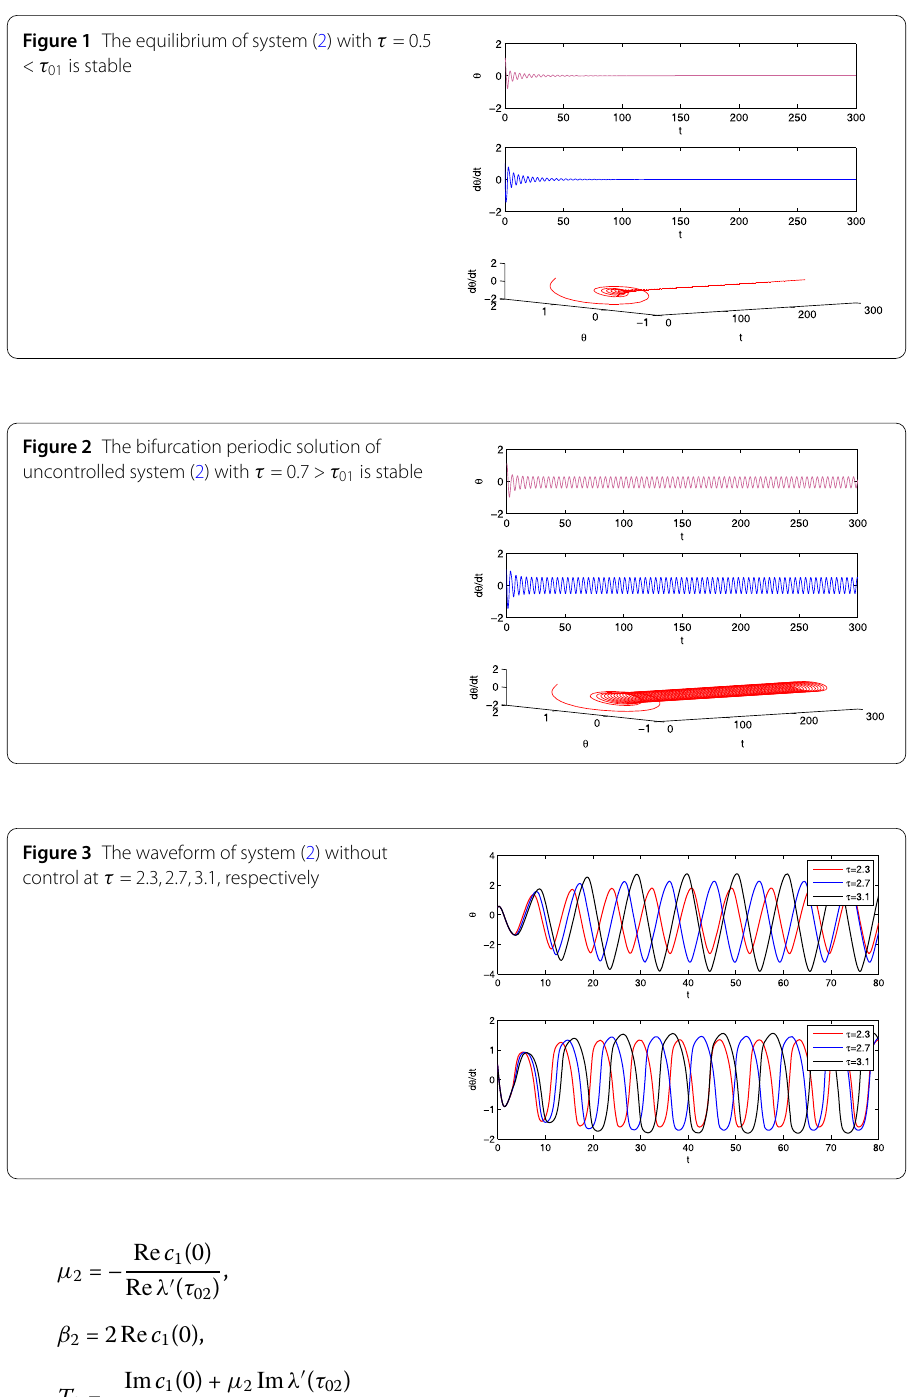
Figure 1 The equilibrium of system (2) with τ = 0.5 < τ 01 is stable